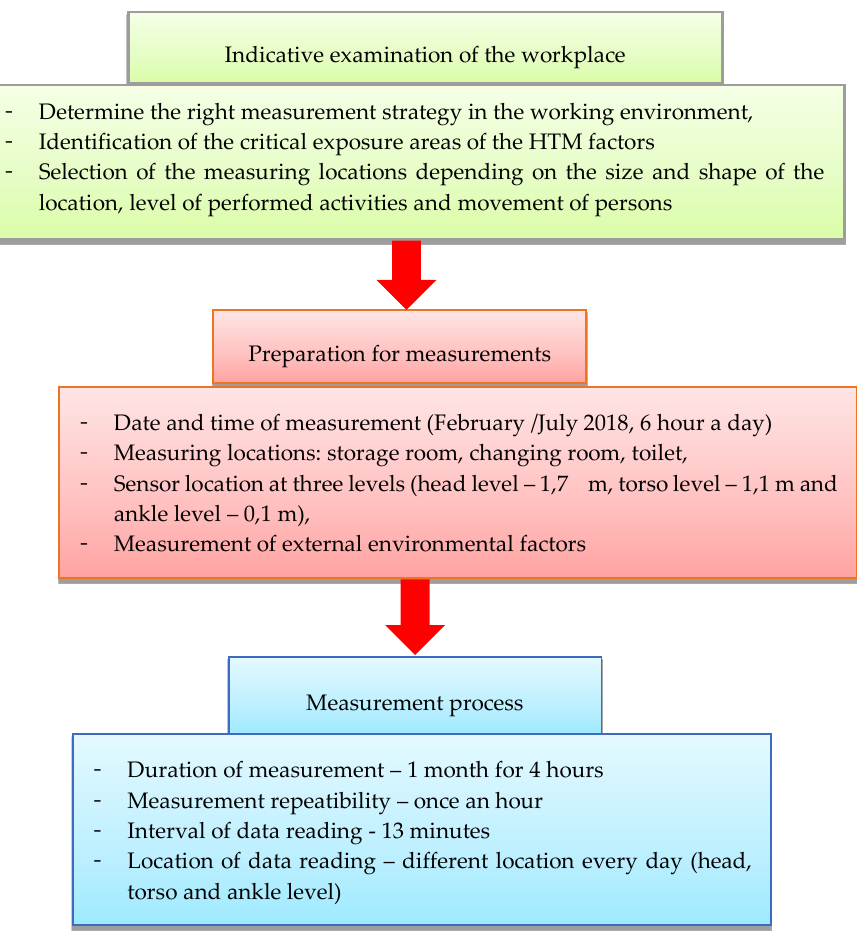
Figure 2. Planned experiment process.